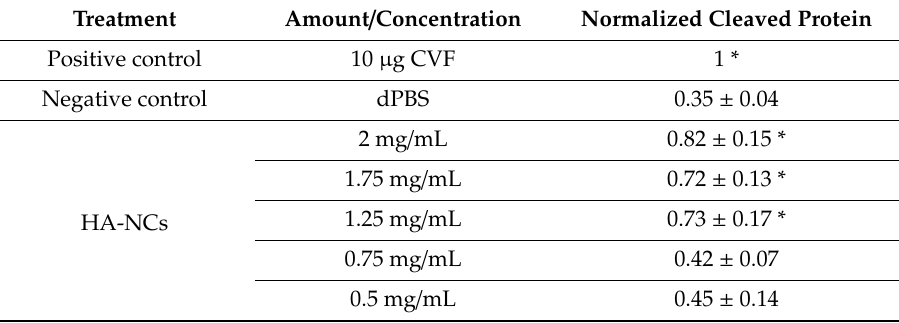
Figure 5. Cytotoxic e ff ect of Hyaluronic acid nanocapsules (HA-NCs, black circles) and its nanoemulsion (NE, white square). RAW 264.7 was incubated with di ff erent concentrations of each formulation for 4 h and after 24 h was analysed by Alamar Blue. Table 2. Complement activation of human plasma induced by di ff erent Hyaluronic acid nanocapsule (HA-NCs) concentrations. The values correspond to the intensity band of Western blot normalized to the Cobra Venom Factor (CVF, positive control). * denotes a significant di ff erence between treatment and the negative control (dPBS). ( p <